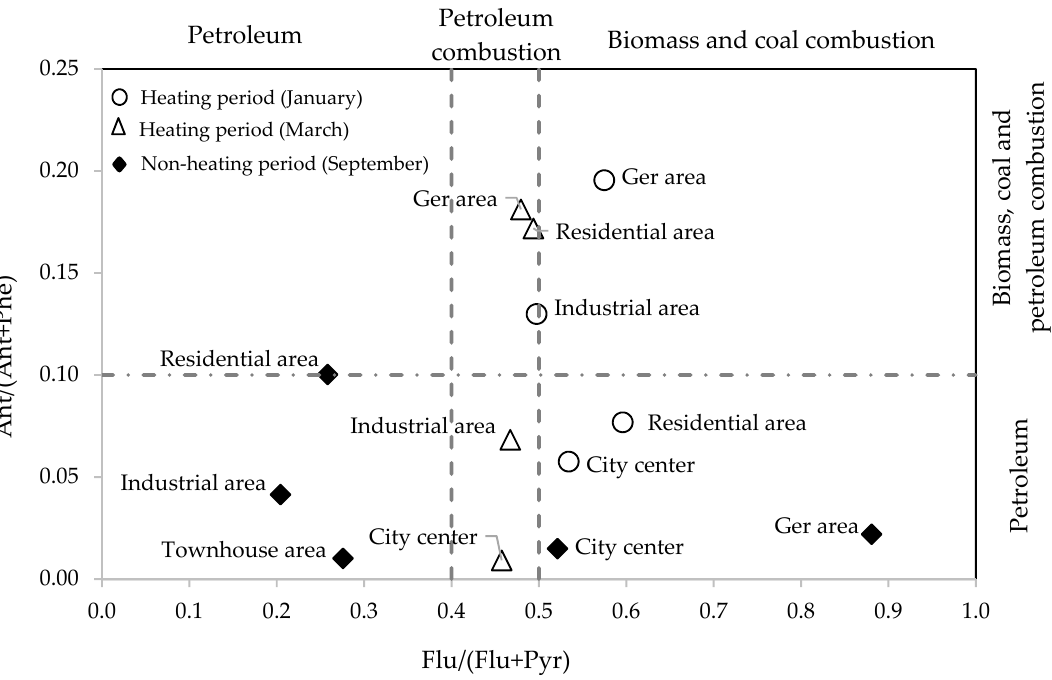
Figure 6. Cross plot of the diagnostic ratios for the sources of PAHs in winter and late summer. In summary, vehicle emission was suggested as the main source of PAHs at the city center even during winter. In other sampling sites, mixed contribution from the biomass and coal combustion, as well as vehicle emission (petroleum combustion) were suggested, but the biomass and coal combustion were prominent in colder periods (winter and spring) especially in the ger, industrial and residential areas. This demonstrates a direct link between high PAH volumes observed in